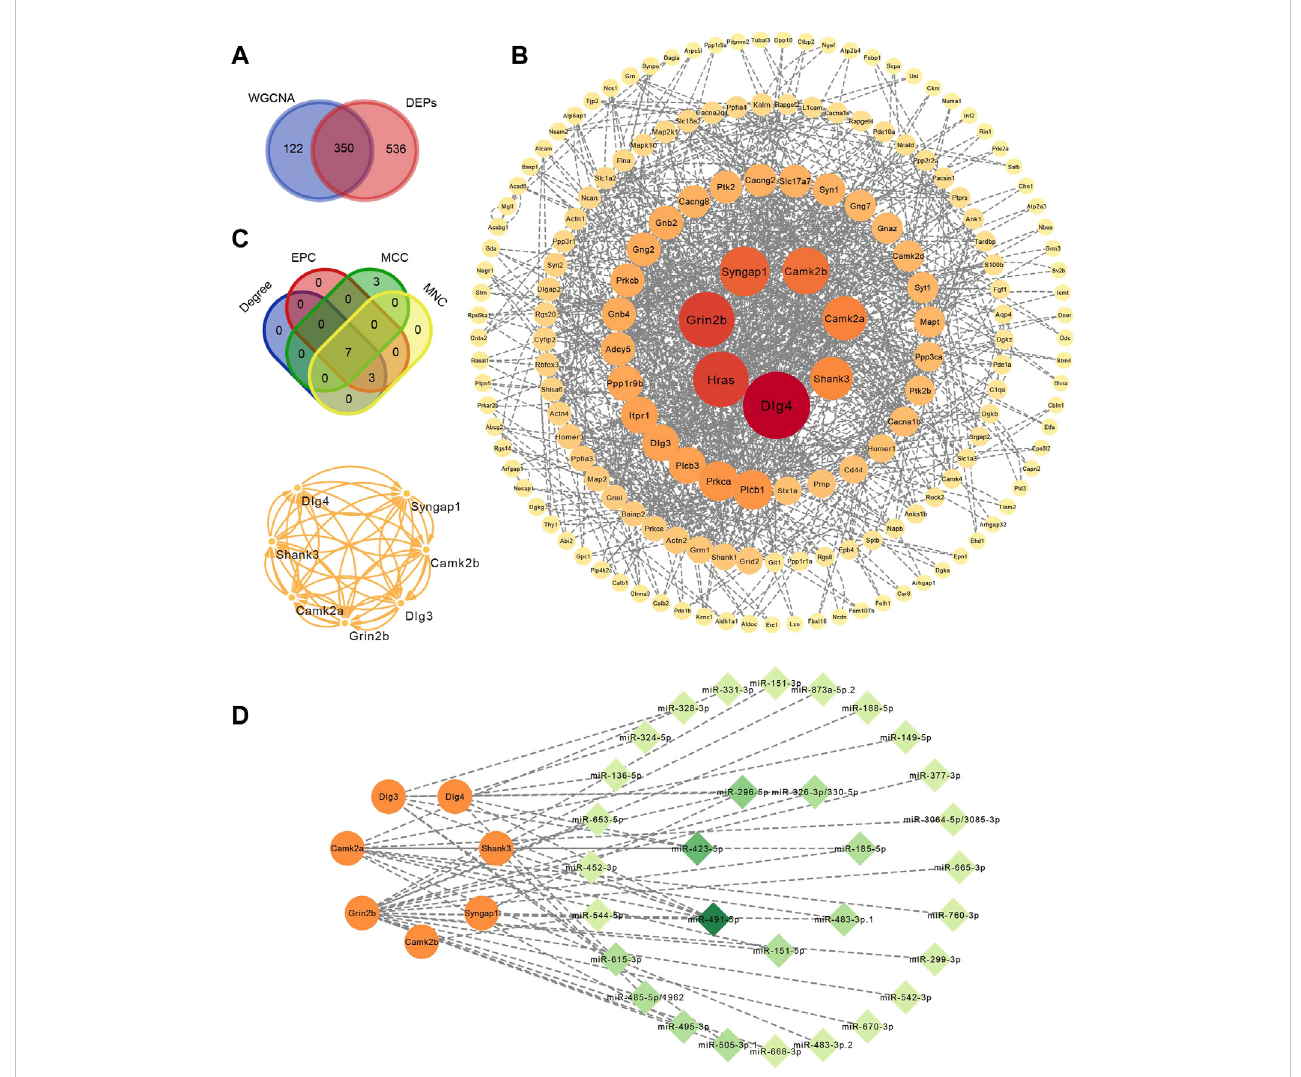
FIGURE 5 Identi fi cation of hub proteins related to alcohol withdrawal. (A) Overlap analysis in 472 proteins in turquoise module (MM > .8 and |GS| > .2) veri fi ed by WGCNA and 886 DEPs. (B) PPI network construction of 350 overlapped proteins related to alcohol withdrawal. (C) Seven hub proteins related to withdrawal identi fi ed by CytoHubba plugins of Cytoscape based on four algorithms: EPC, MCC and MNC. (D) miRNA – mRNA interactions network. Orange circle represents hub proteins and green diamond miRNA. The deeper the color and the larger the circle, the greater the